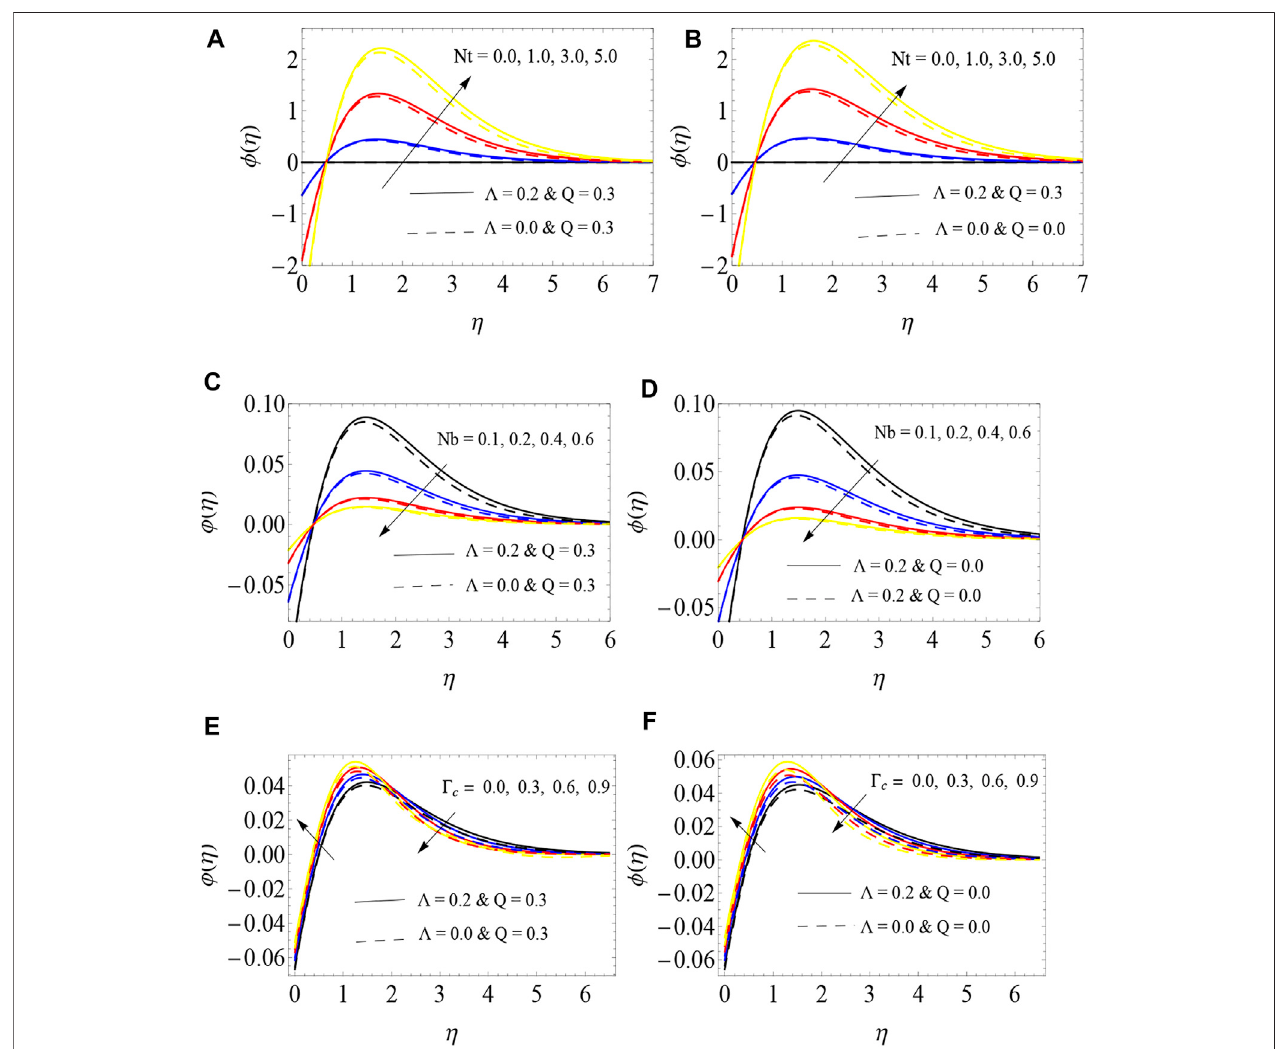
FIGURE 5 | The impact of “ Nt, ” “ Nb, ” and “ Γ c ” on nanoparticle volume fraction pro fi le.